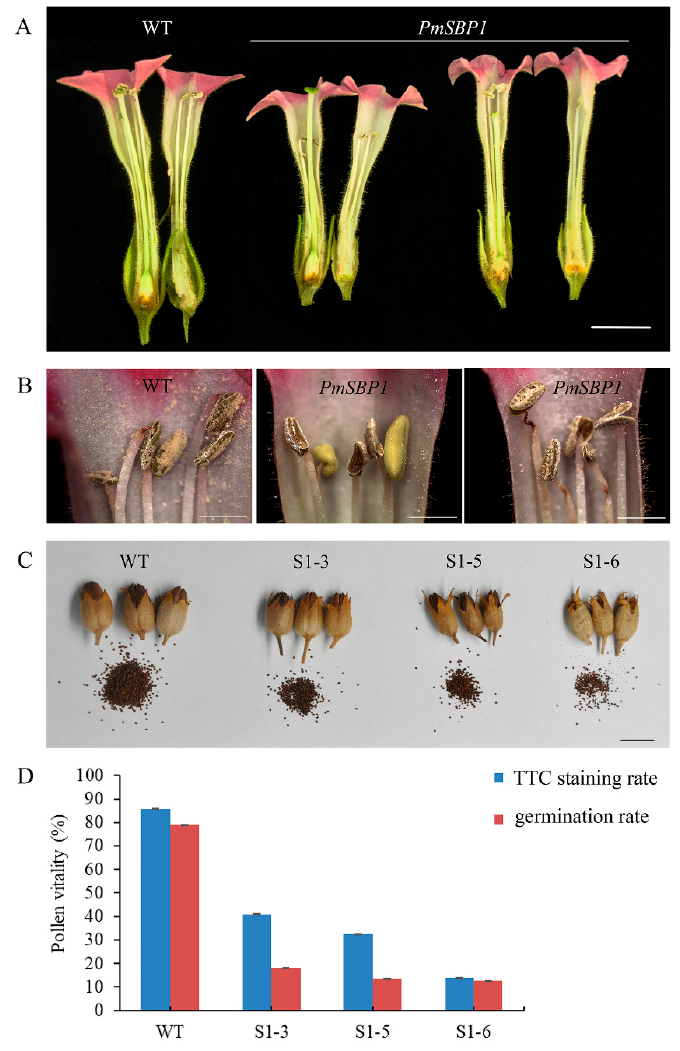
Figure 6. The phenotype of reproductive organs and pollen vitality of PmSBP1 transgenic tobacco. ( A ) The floral organs of PmSBP1 transgenic plants. ( B ) The anther morphology of PmSBP1 transgenic plants. ( C ) The pod size and seed number from one pod in the PmSBP1 transgenic plants. ( D ) The pollen vitality of PmSBP1 transgenic plants. The scale bar in ( A , C ) = 1 cm. The scale bar in ( B ) = 2